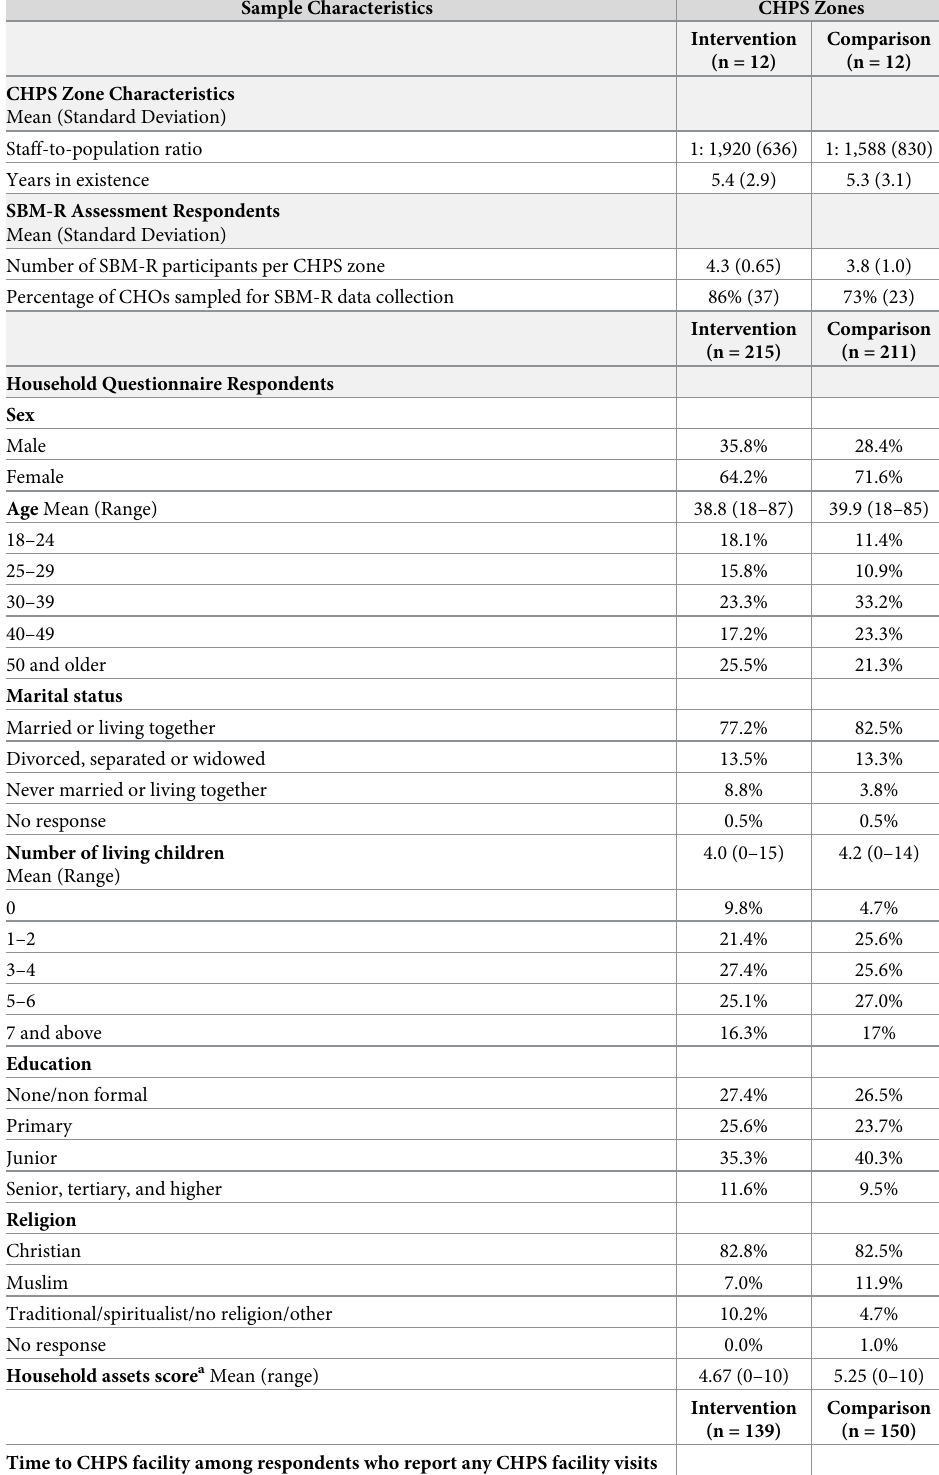
Table 2. Sample characteristics of facilities included in SBM-R assessment and household questionnaire, by study